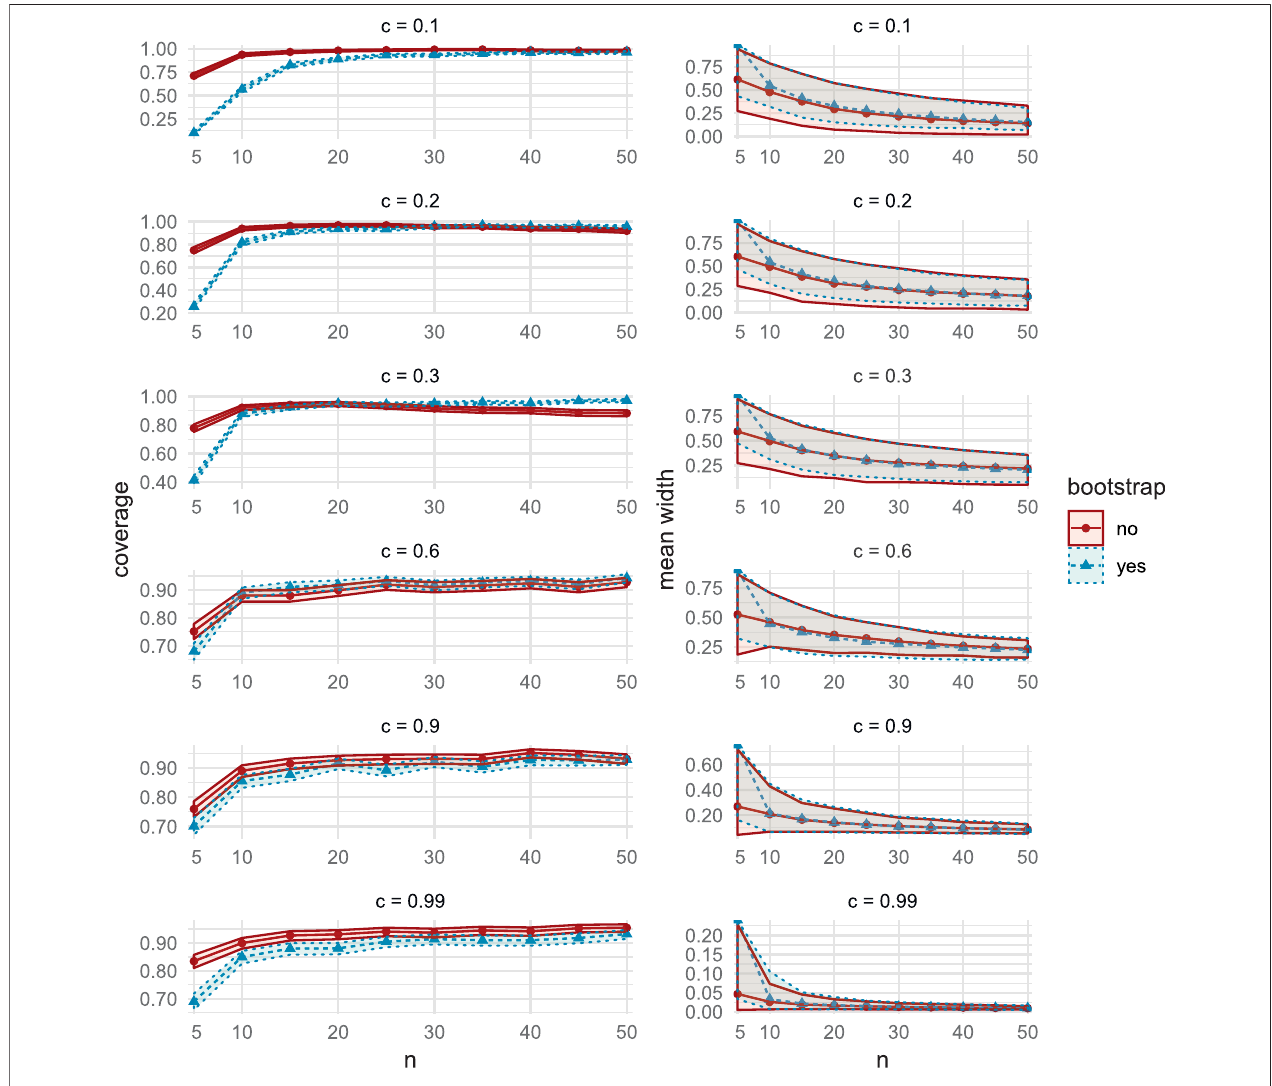
FIGURE 12 | Comparisons of coverage (left column) and mean width (right column) , between the bootstrap CIs (dashed lines with triangular markers) and the asymptotic CIs (solid lines with circular markers) in MC Study A. Rows represent correlations c, increasing from 0:1 on the top row to 0:99 on the bottom row. The horizontal axes display the sample sizes n (cid:2)